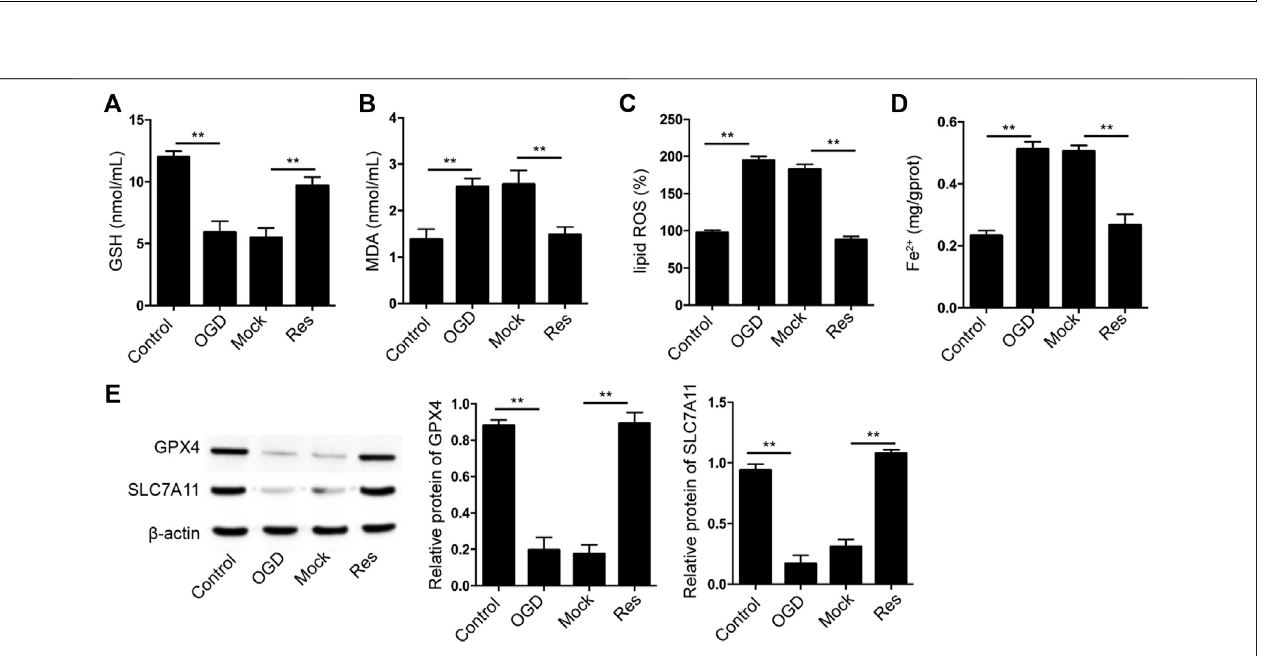
Frontiers in Pharmacology |